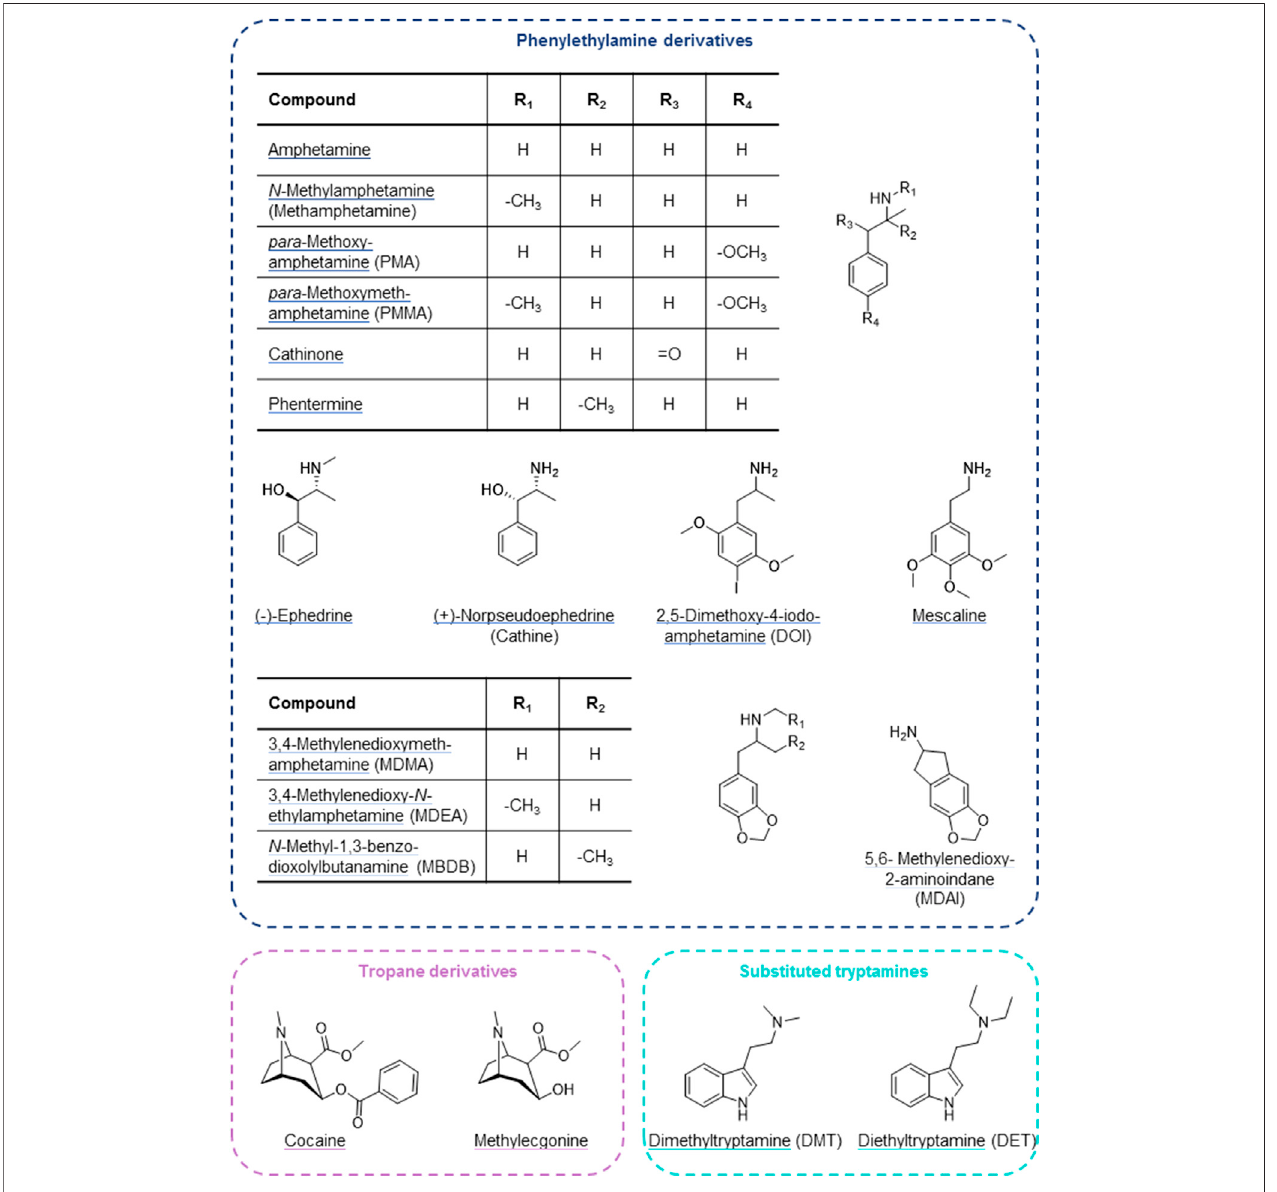
FIGURE 1 | Psychostimulant and hallucinogenic drugs assessed for cell uptake by OCTs and high-af fi nity monoamine transporters.